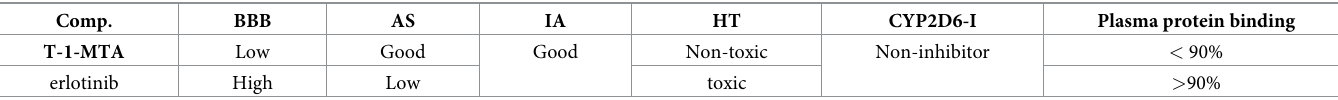
Table 3. ADMET parameters for T-1-MTA and erlotinib. Comp.